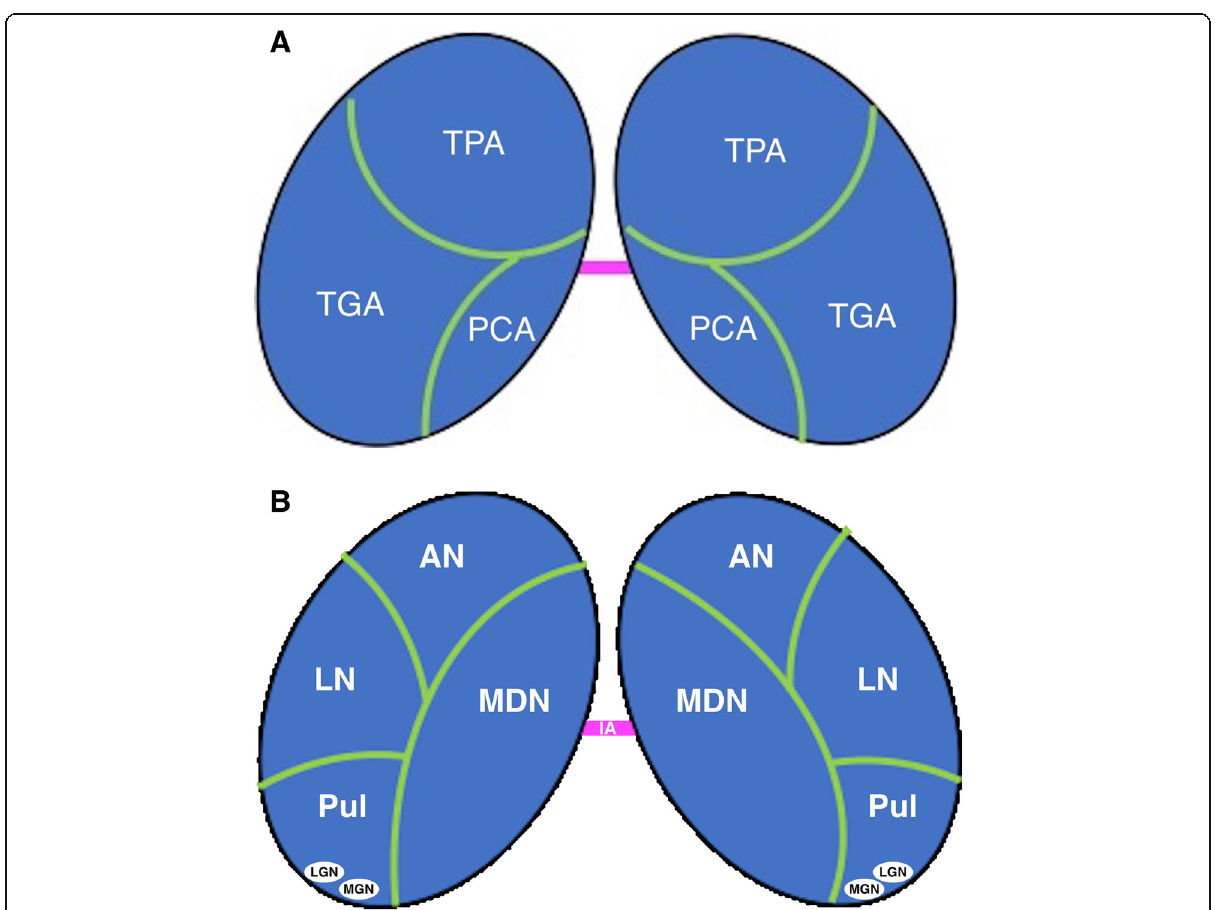
Fig. 1 Diagrams show the different anatomic regions of the thalamus ( a ) and its vascularisation ( b ). TPA, thalamoperforating arteries; TGA, thalamogeniculate arteries; PCA, posterior choroidal artery; AN, anterior nucleus; LN, lateral nuclei; MDN, mediodorsal nuclei; Pul, pulvinar; LNG, lateral geniculate nucleus; MGN, medial geniculate nucleus